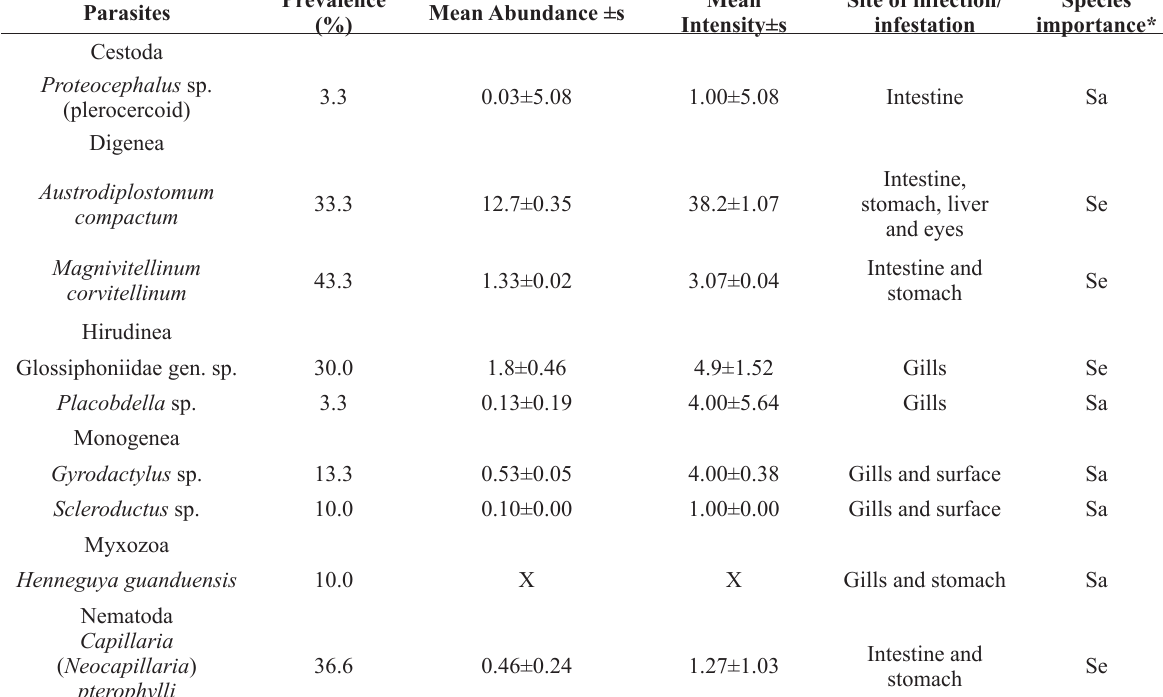
Prevalence, mean abundance, mean intensity and site of infection of the metazoan parasites of Hoplosternum littorale (Hancock 1828) collected in the Lagoa Cabeça de Boi of the Peixe River, Middle Tietê, São Paulo, Brazil. s= standard deviation.